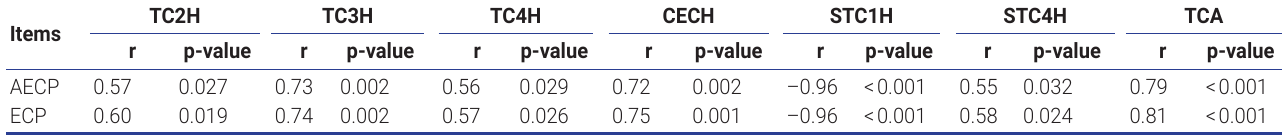
Table 9. Correlation between FTIR carbohydrate structures and the NRC system for canola seeds Items